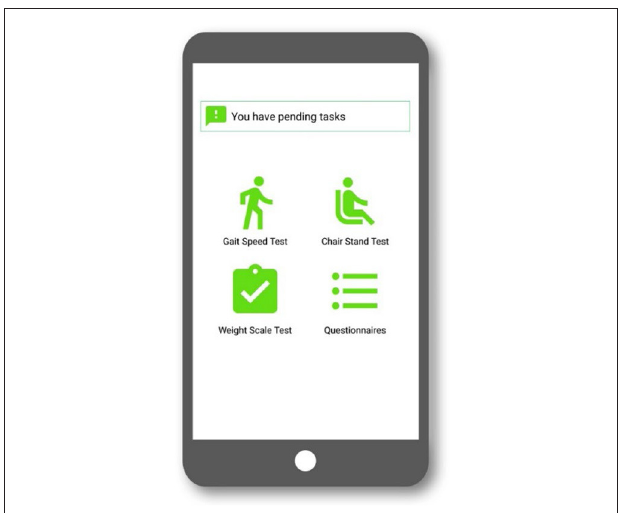
At the main screen of every task, an “Exit” button appeared in the lower-right corner of the screen. Having different ways to navigate to the main screen was confusing for test participants (see Figure 7